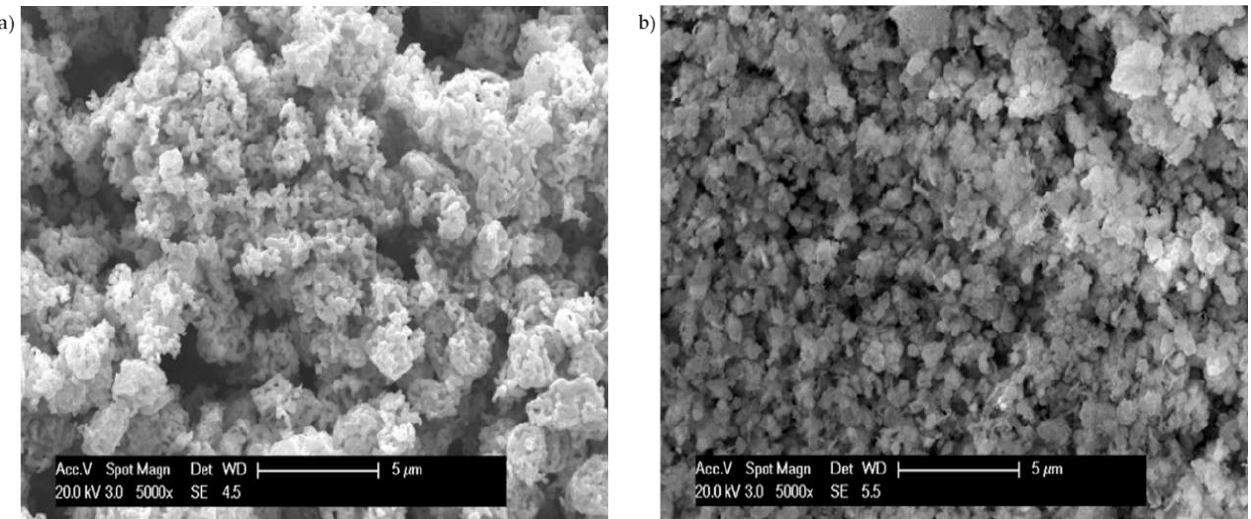
Figure 3. SEM images of in-house-synthesized Ni ( a ) and NiCu ( b ) catalysts.